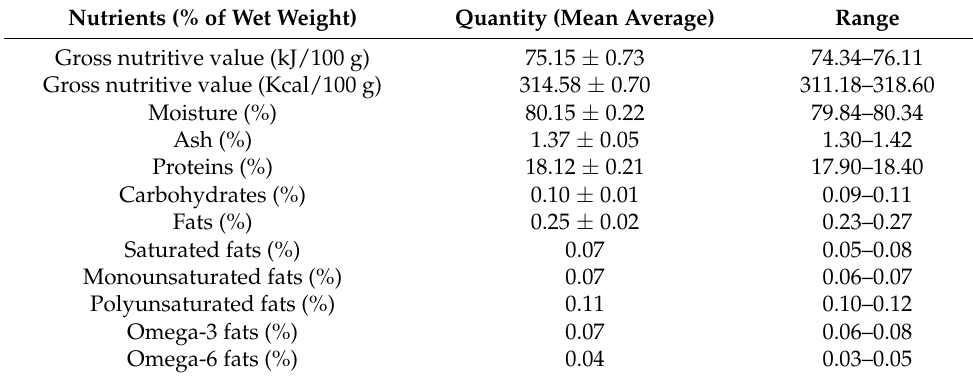
Table 2. Nutritive value of spiny-cheek crayfish. Nutrients (% of Wet